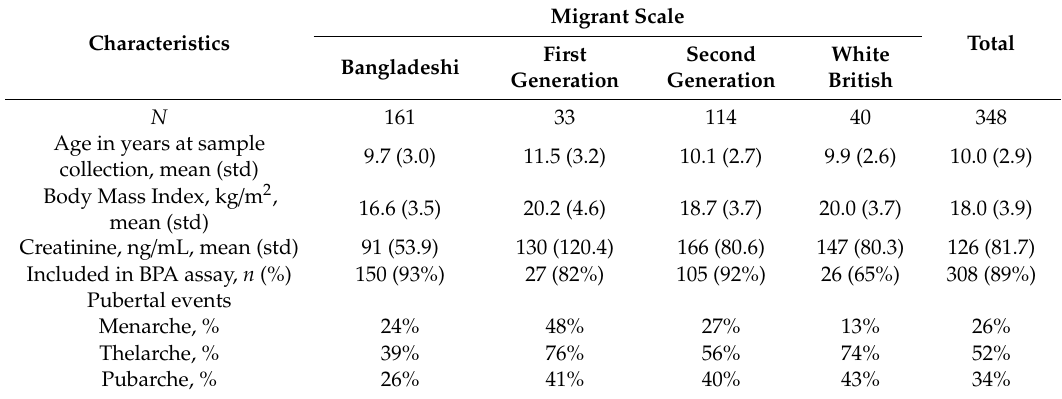
Table 1. Characteristics of the study sample of British and Bangladeshi girls 5–16 years of age with urine samples, Adolescence among Bangladeshi and British Youth (ABBY) Project ( n =